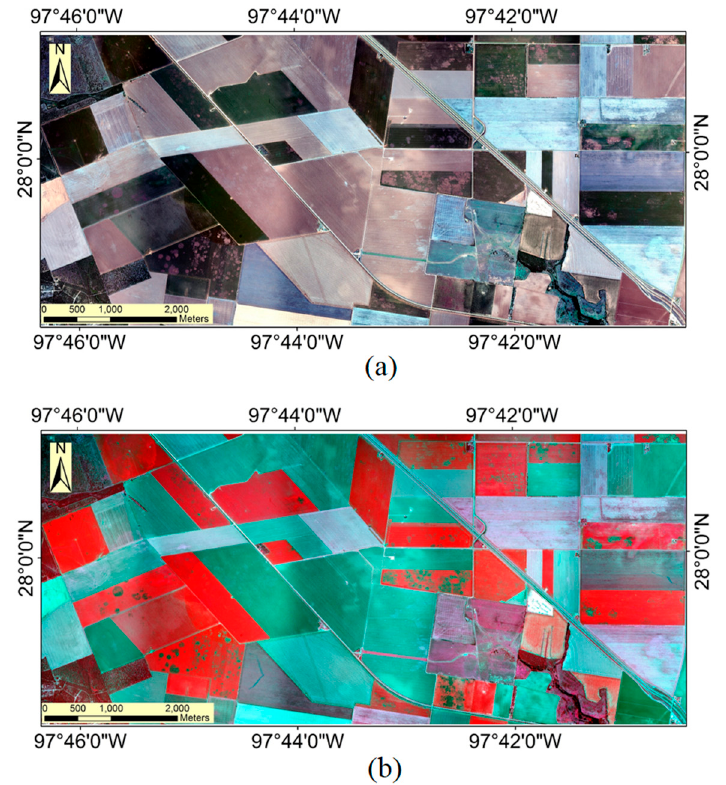
Figure 2. Mosaicked airborne images for the study area. ( a ) True color image; ( b ) color infrared (CIR) composite image.